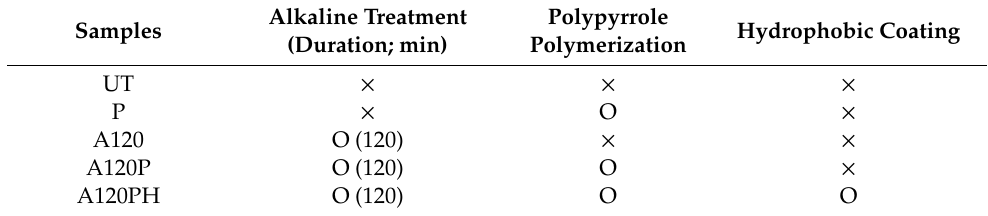
Figure 1. Illustration of experiment procedure for polyvinylidenefluoride (PVDF) film. Table 1. Sample code and treatment description.